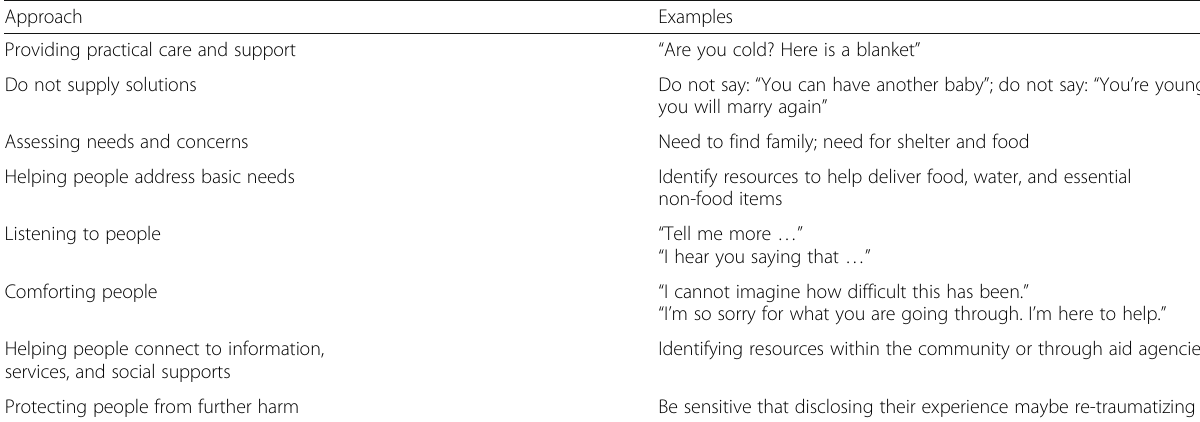
Table 6 Psychological first aid